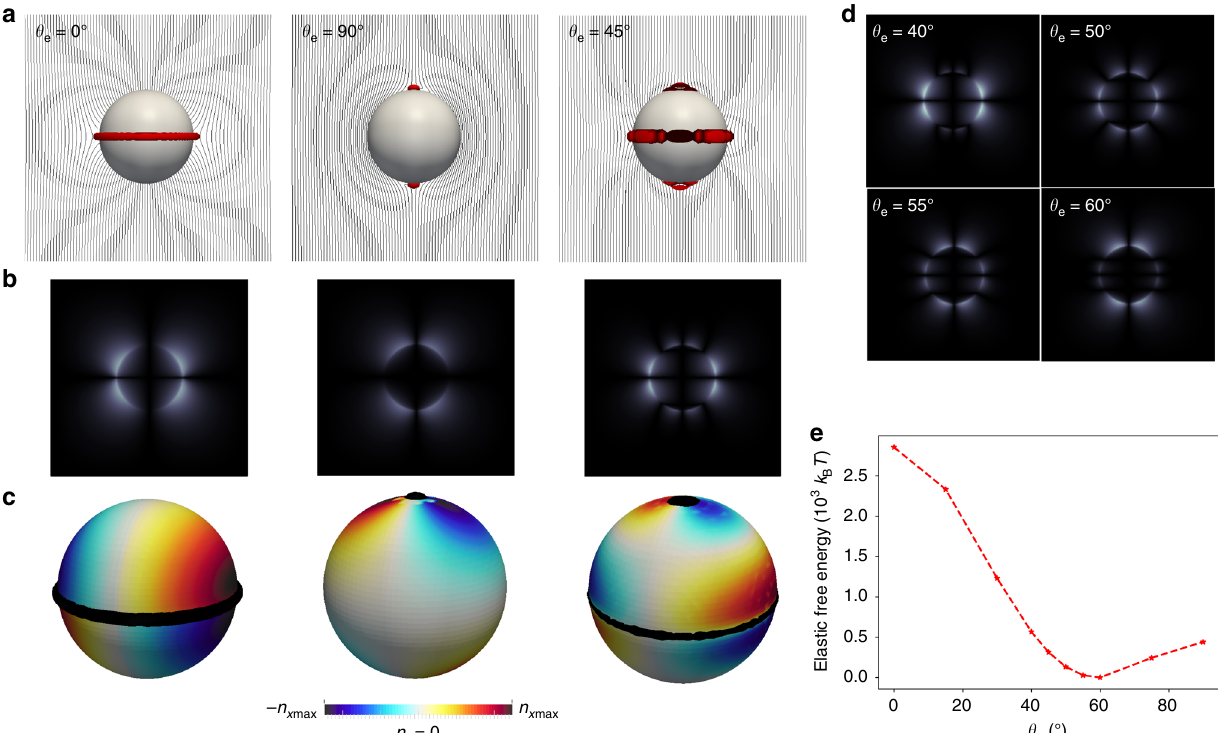
Fig. 1 Elastic quadruple and hexadecapole. a Director fi elds for nematic colloids ( R = 250 nm) with θ e = 0°, 90°, and 45°, respectively. Defects are shown in red (isosurface for S = 0.6). b Corresponding simulated polarized light micrographs for nematic colloids with θ e = 0°, 90°, and 45°. The brightness of the images for θ e = 0° and 90° is reduced by half for the purpose of comparisons. The far- fi eld director is parallel to the polarizer or analyzer. c Color map of the directors ’ x -component ( n x ) on the colloid surface. d Simulated polarized light micrographs for nematic colloids with θ e = 40°, 50°, 55°, and